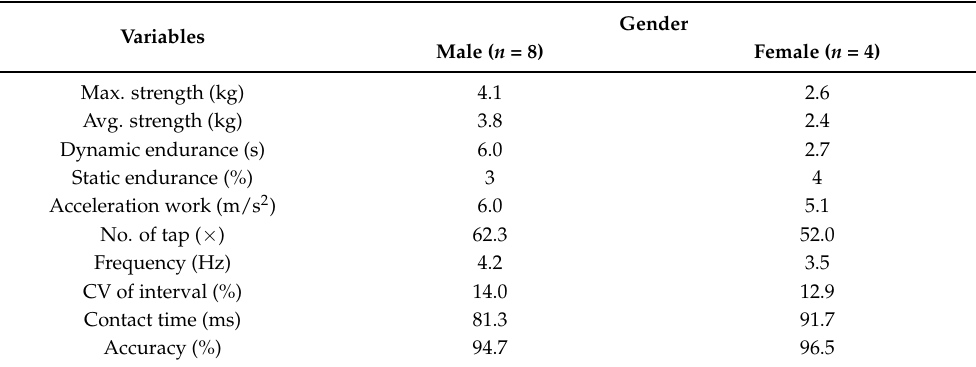
Table 4. Finger tapping results of 12 healthy men and women in their 20s.